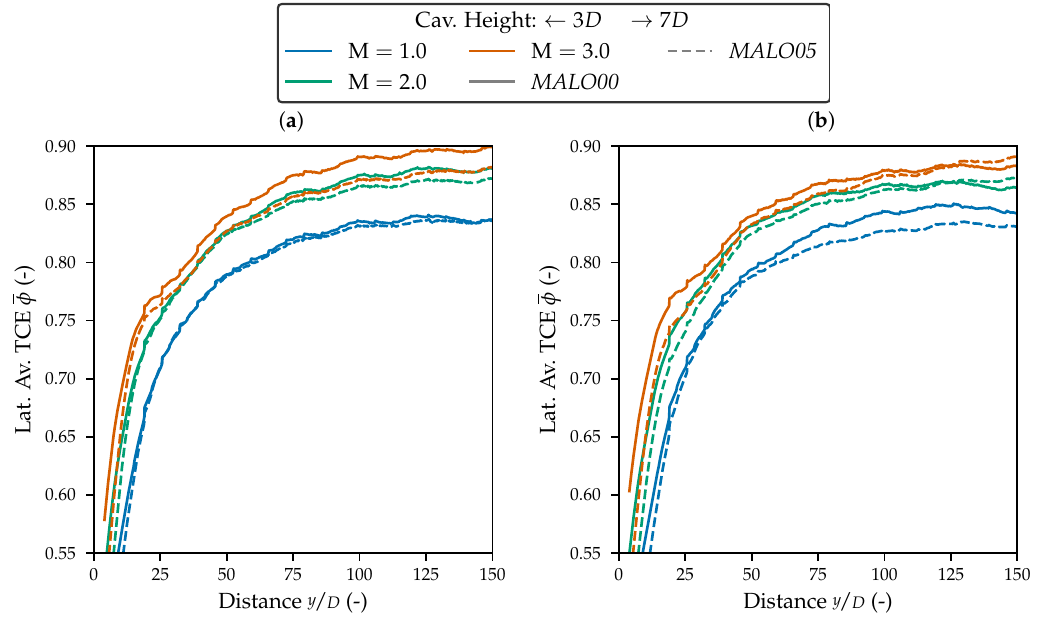
Figure 6. Laterally averaged total cooling effectiveness on hot gas side: ( a ) small cavity height 3 D , ( b ) large cavity height 7 D